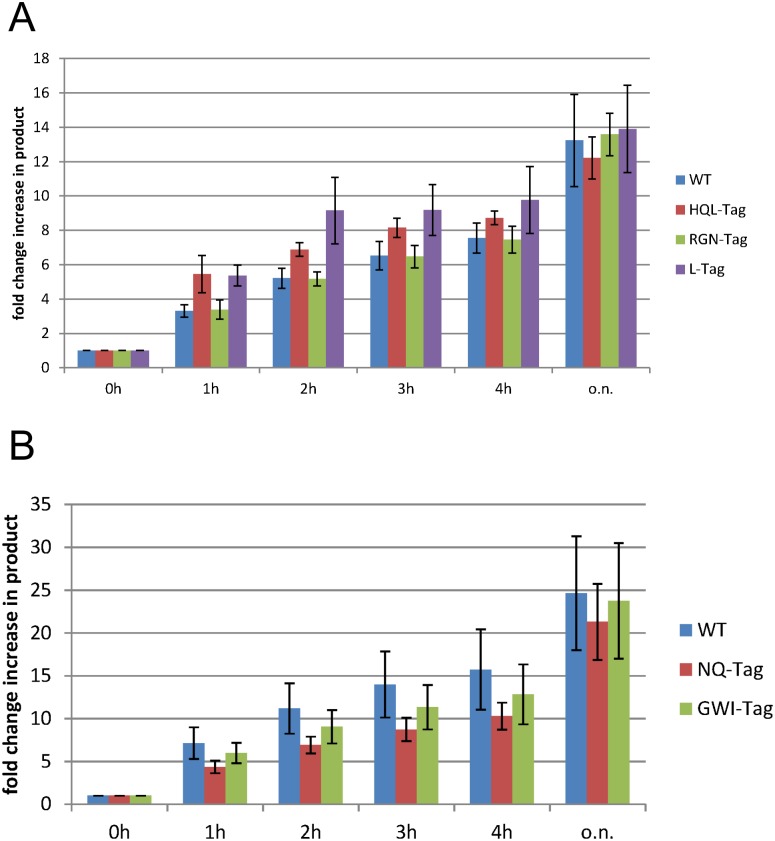
Bar diagrams summarizing the quantified reconstitution rates for (A) 4oq1 variants and (B) 3kptC variants.For each time point, the reconstitution of the wiltype-tag and different tag-variants is compared (please refer to Fig 11 for the exact sequence of the different tag variants). Each value represents the average over 3–4 independent experiments. o.n. = over night (24 h). Purified mCherry-catcher (15μM final conc.) and respective purified tag-MBP (15μM final conc.) were mixed at 25°C with shaking (500rpm) and a time course of covalent bond formation was performed (0h, 1h, 2h, 3h, 4h, o.n. = over night). Samples were boiled (10min, 95°C) prior to gel loading. Four independent assays per catcher-tag pair were performed (triplicate for mCherry-3kptCC-3kptCT(NQ)) and analyzed via densitometry (ImageJ). Based on the band intensities in the gel mean values and standard deviation were calculated.